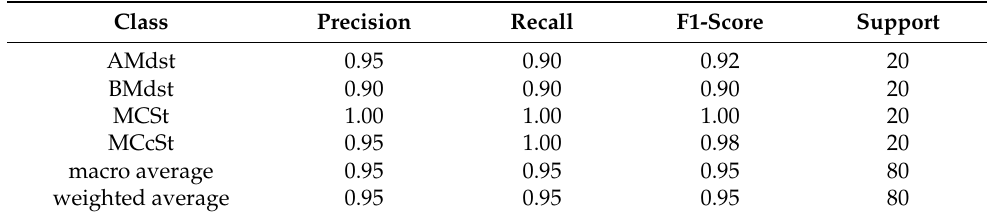
Table A5. Classification report for ResNet18 pretrained on ImageNet. The overall accuracy is 0.95.